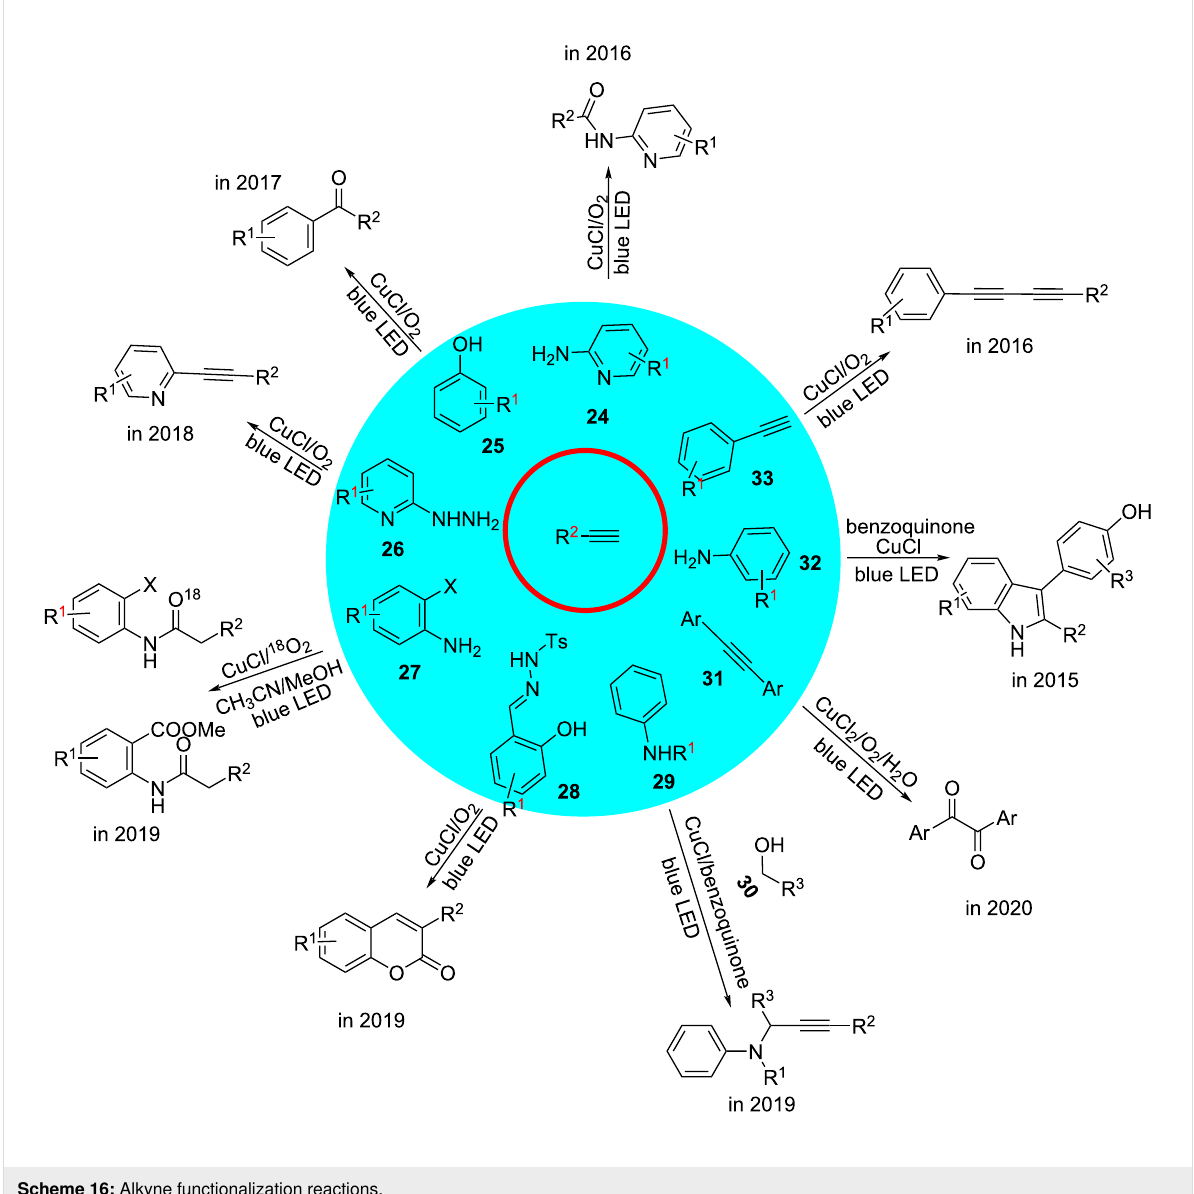
Scheme 16: Alkyne functionalization